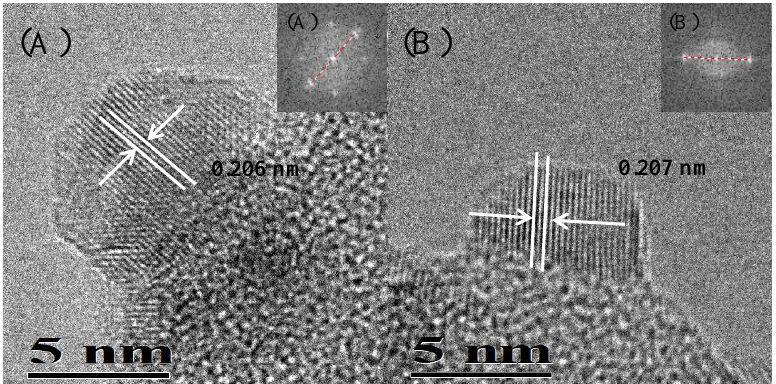
Figure 4. HRTEM image of ( A ) NiCu 0.125 / MCM-41, ( B ) NiCu 0.5 / MCM-41, the image inset in ( A ) and ( B ) are the corresponding Fast Fourier Transform (FFT) patterns.